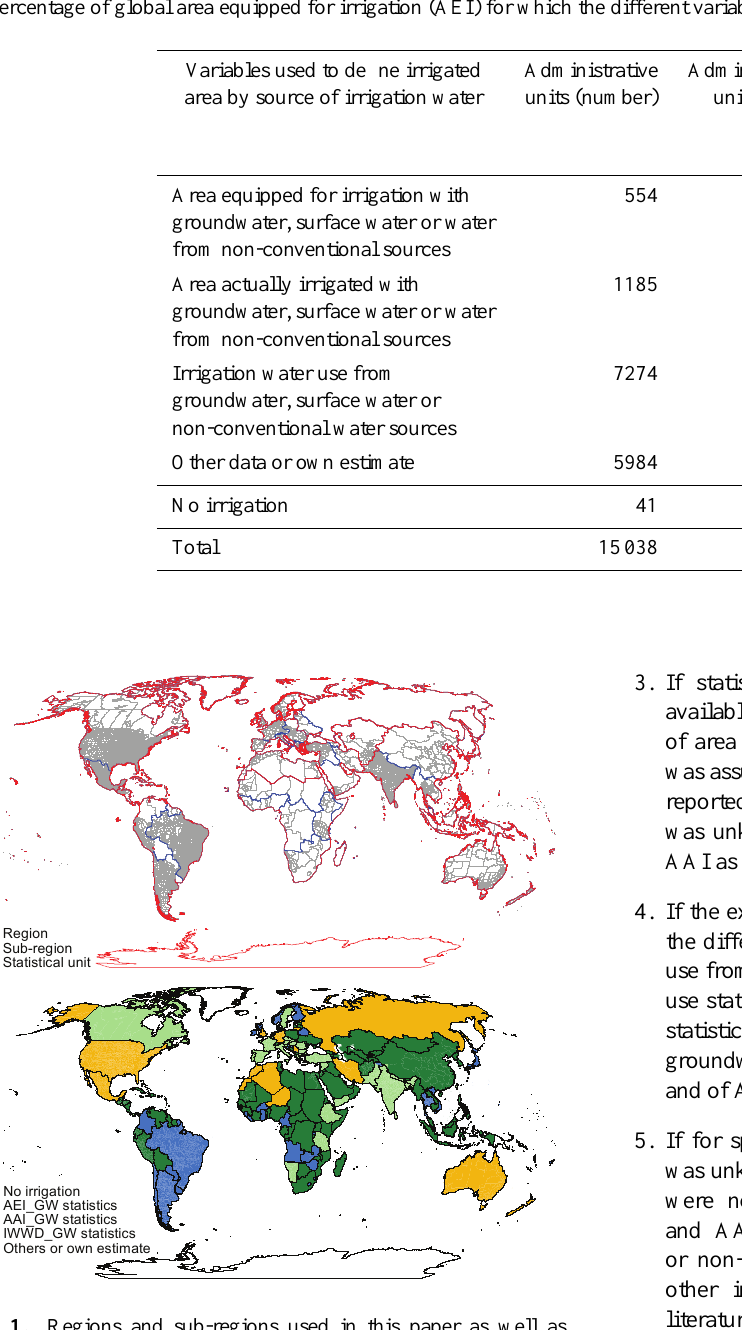
Fig. 1. Regions and sub-regions used in this paper as well as administrative units distinguished in the groundwater irrigation inventory (top), and type of input data used to develop the inventory (bottom). AEI GW=area equipped for irrigation with groundwater, AAI GW=area actually irrigated with groundwater, IWWD GW=groundwater withdrawals for irrigation (see the electronic Supplement for a high resolution version of this